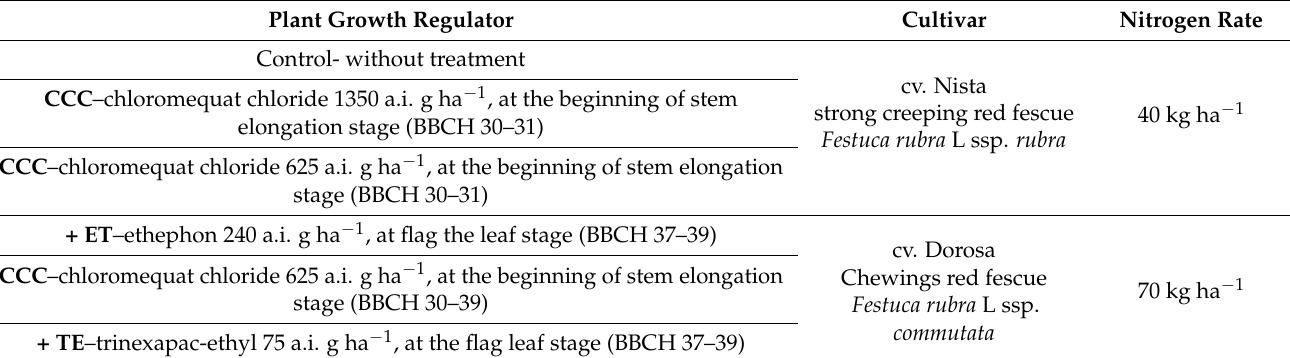
Table 1. Experimental